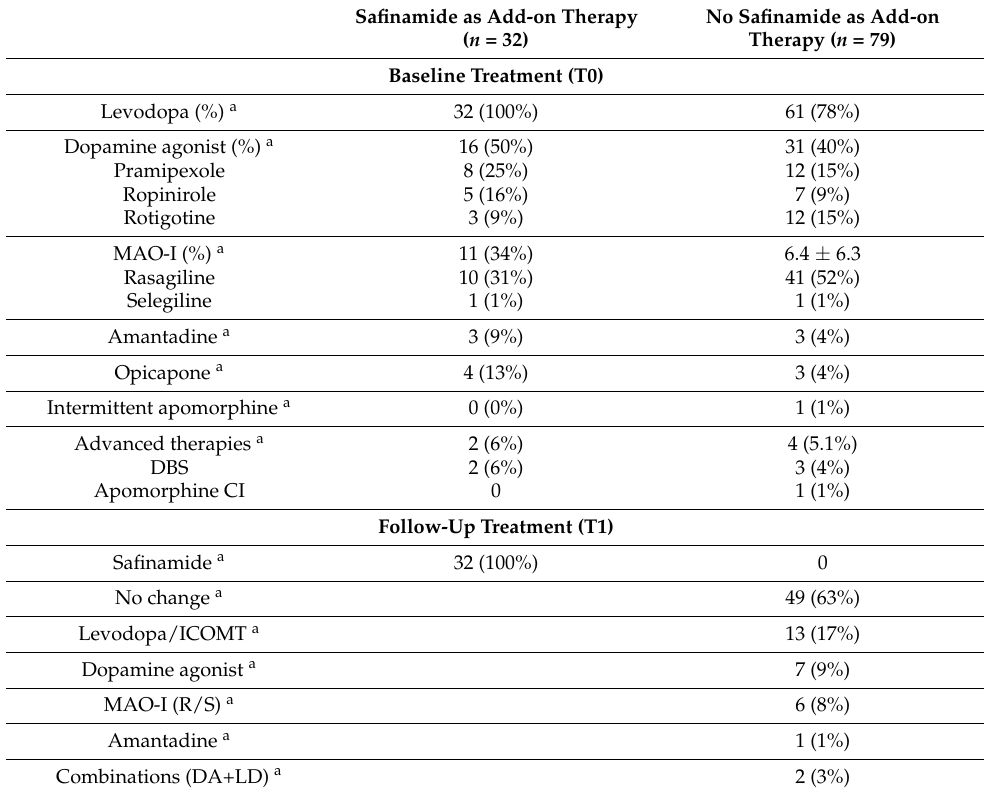
Table 2. Treatment regime in both groups at baseline and follow-up.